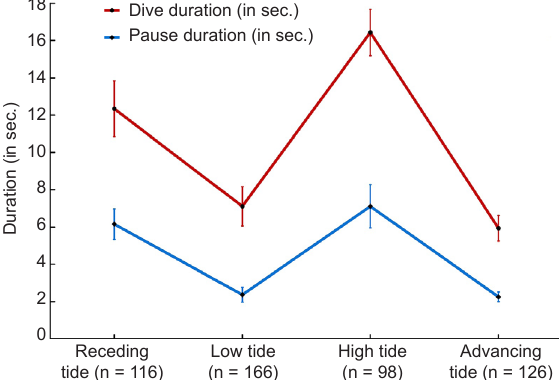
Receding tide (n = 116) Figure 1. Pause duration (recovery time in seconds) as a function of dive duration performed by Little Cormorant at different tidal